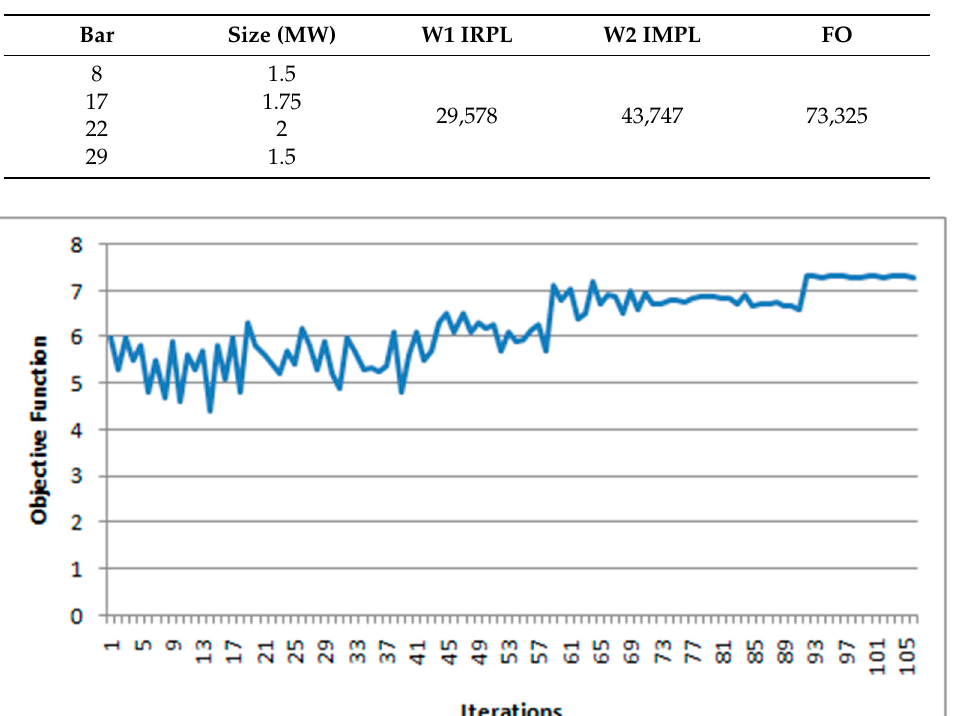
Table 4. Best result using simulated annealing (SA) .